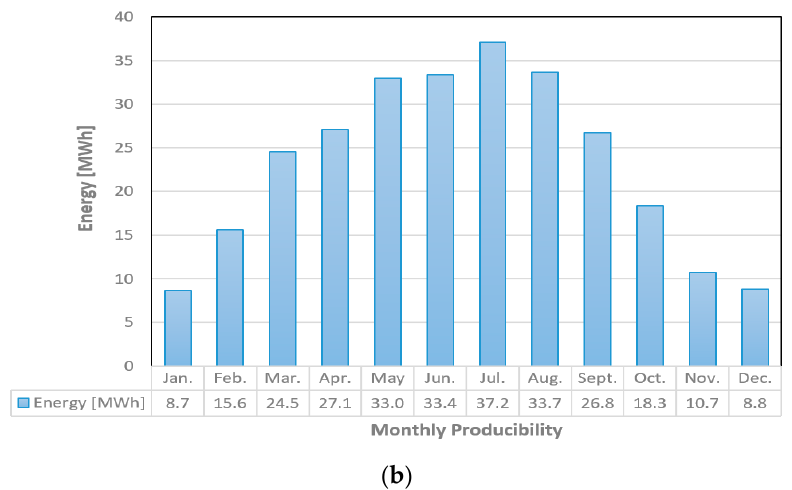
Figure 14. ( a ) Daily output power of the photovoltaic (PV) plant month by month and ( b ) overall monthly producibility of the PV plant.